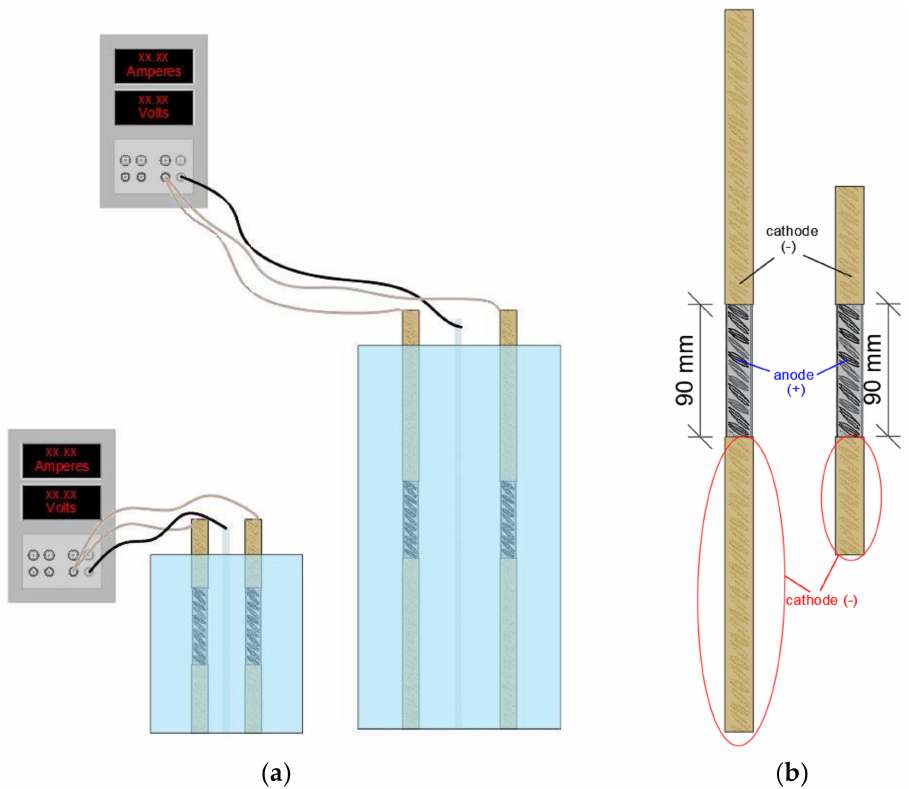
Figure 11. Schematic presentation of ( a ) electrical closed circuit for both group of specimens ( b ) differential aeration